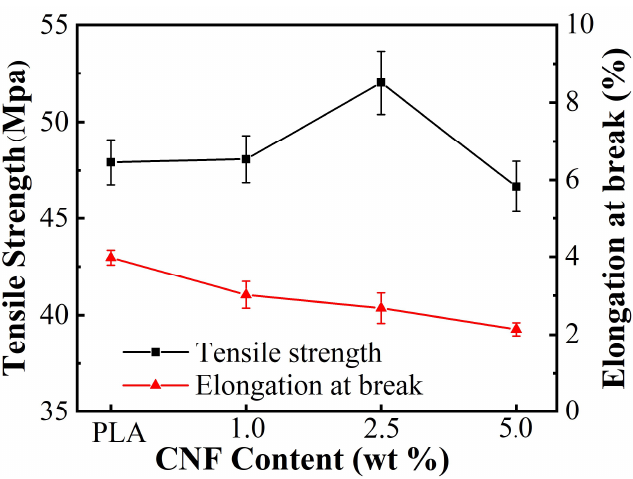
Figure 9. Tensile properties PLA/CNF biocomposite films with different CNF